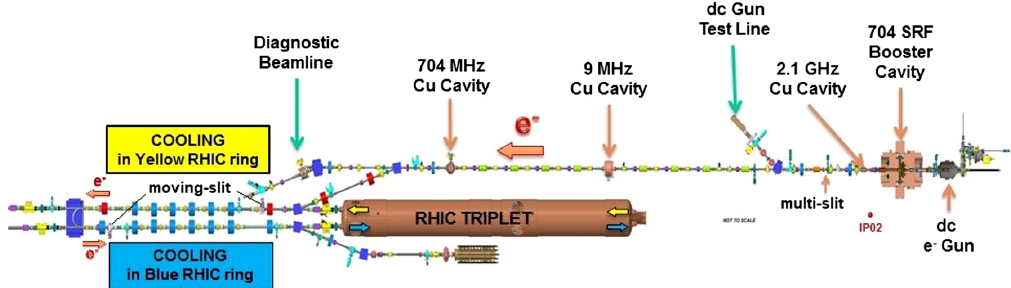
FIG. 3. Schematic of the Low Energy RHIC electron Cooling accelerator. Electron beam is accelerated by a 704 MHz superconducting rf cavity to the required energy and then transported to the RHIC cooling sections. First they merge with ion bunches in the Yellow ring cooling section, before turning around and merging with ion bunches in the Blue RHIC ring. Finally they are transported to a